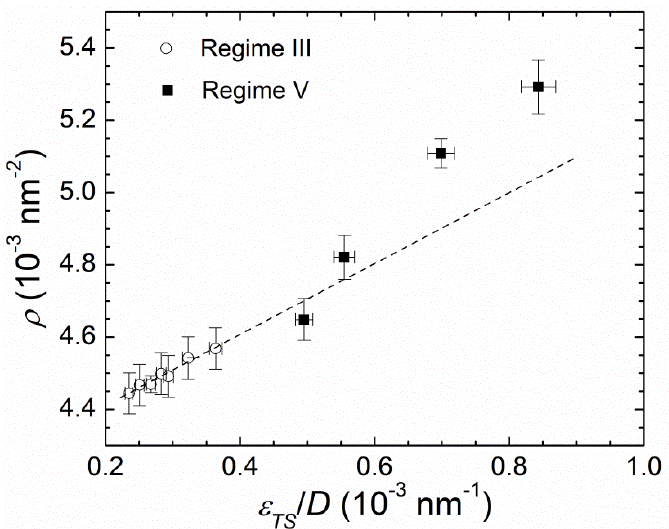
Figure 6. True applied stress,  𝑇𝑆 , vs. the square root of dislocation density,  1/2 , for nc-Ag plastically deformed in Regimes III and V, respectively. Dashed straight lines represent linearly fitted data.